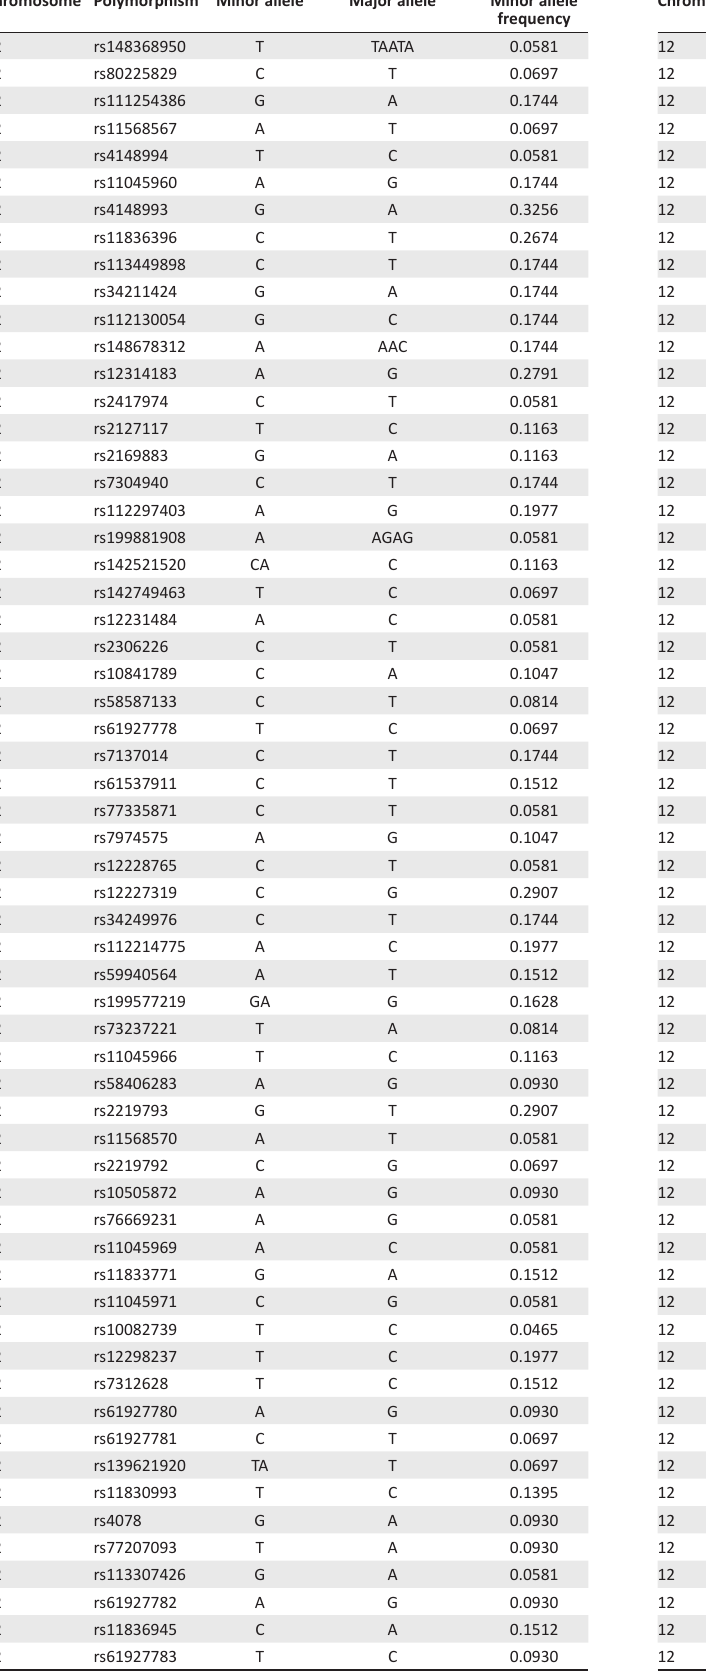
Table 1-A1 continues on the next page →Table 1-A1 continues in the next column